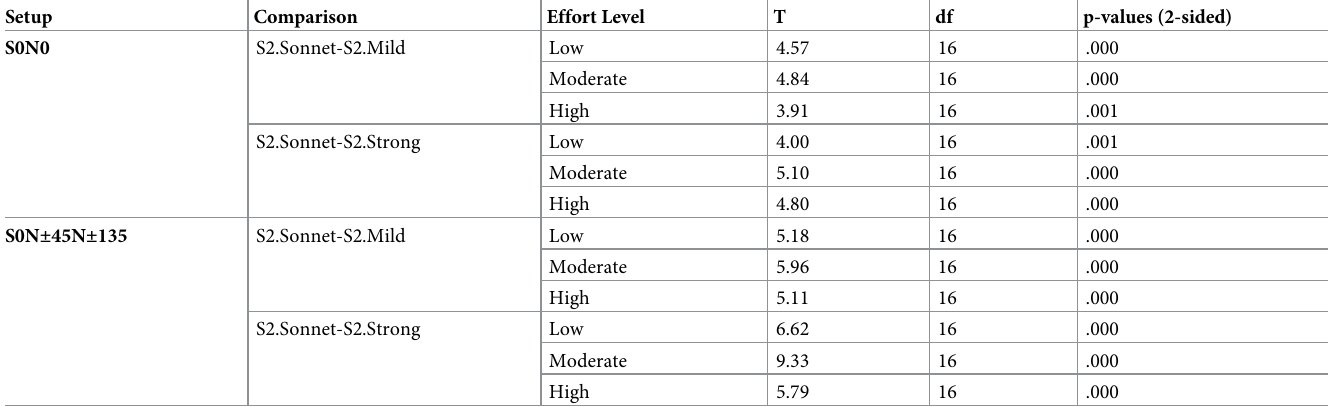
Table 5. One-sample t-tests of the ACALES results. Setup